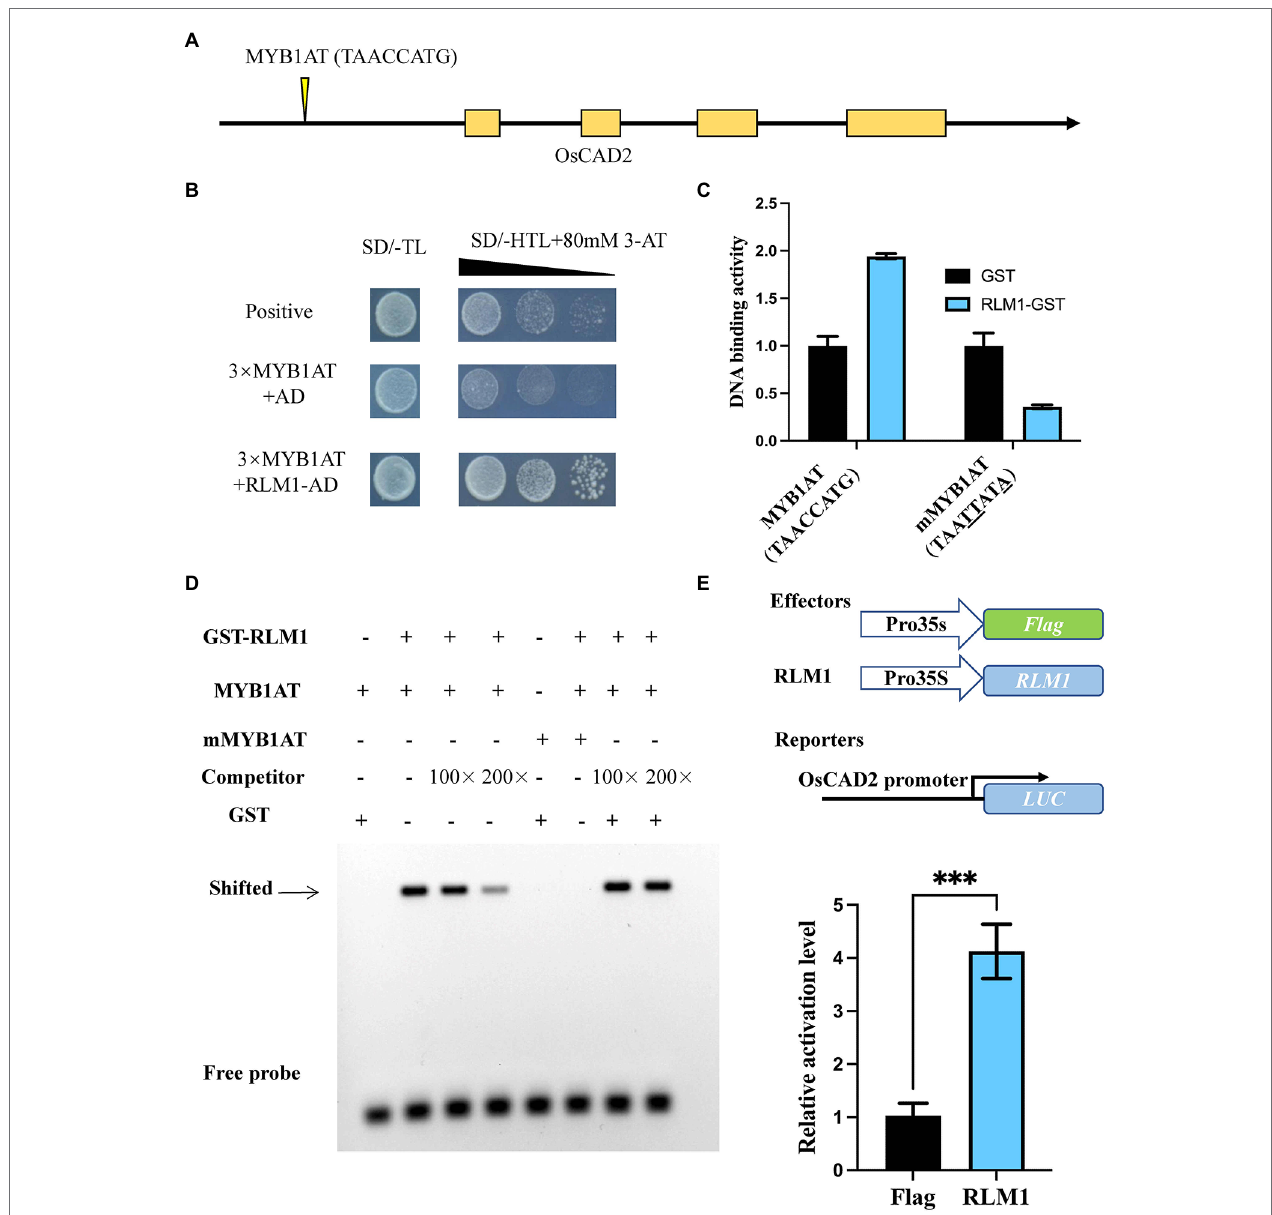
FIGURE 5 | RLM1 binds to the motif of OsCAD2 and activates its expression. (A) The MYB1AT motif box is located approximately 1,931–1,938 bp upstream of the OsCAD2 start codon. (B) A Y1H assay was used to test RLM1 binding to the MYB1AT motif. An AD-only vector was used as a control. (C) DNA-protein binding assay revealing that RLM1 binds to the MYB1AT motif in the OsCAD2 promoter. MYB1AT, TAACCATG; mMYB1AT, TAATTATA. (A) Schematic diagram of OsCAD2 . MYB1AT (TAACCATG) indicates the position in the OsCAD2 promoter. (B) Y1H assays show that RLM1 can bind to the MYB1AT motif, compared with the binding of the negative and positive controls. (C) DNA-binding activity of each group. GST was used as a negative control. The data are presented as the means ± SDs ( n = 3). (D) EMSA shows that the GST-RLM1 recombinant protein directly binds to the biotin-labeled probe of the OsCAD2 promoter fragment. The signal in the RLM1 group and the MYB1AT motif in the OsCAD2 promoter shifted, but no signal shift was found in the RLM1 or mutant MYB1AT group. The shifted signal became increasingly weaker and eventually was no longer detected when unlabeled competitive probes were added. MYB1AT, TAACCATG; mMYB1AT, TAATTATA. (E) RLM1 induces proOsCAD2::LUC signaling. LUC activity was detected in rice protoplasts. The expression of REN was used as an internal control. The LUC/REN ratio indicates the expression level of the promoter ( n = 3). *** p < 0.001 (Student’s t